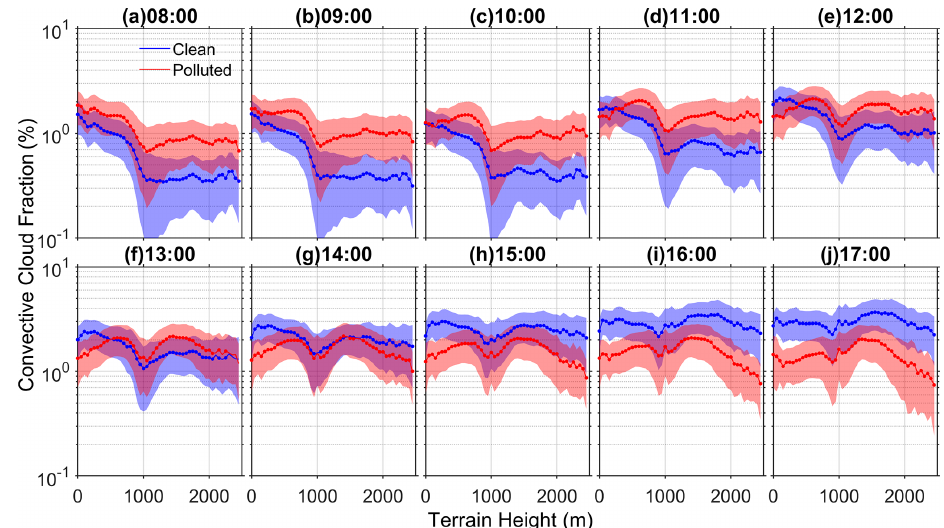
Figure 9. Convective cloud fraction (CCF) normalized by the total number of cases with respect to terrain height changes during May– September 2016/17. Data for polluted conditions (CCF P ) are plotted in red, whereas those for clean conditions (CCF C ) are shown in blue. Solid lines and shaded parts are the mean values and SDs of the fractions in each TH bin. Dots are plotted only if the difference between clean and polluted cases exceeds the 95% significance level ( p < 0.05) according to Student’s t test.